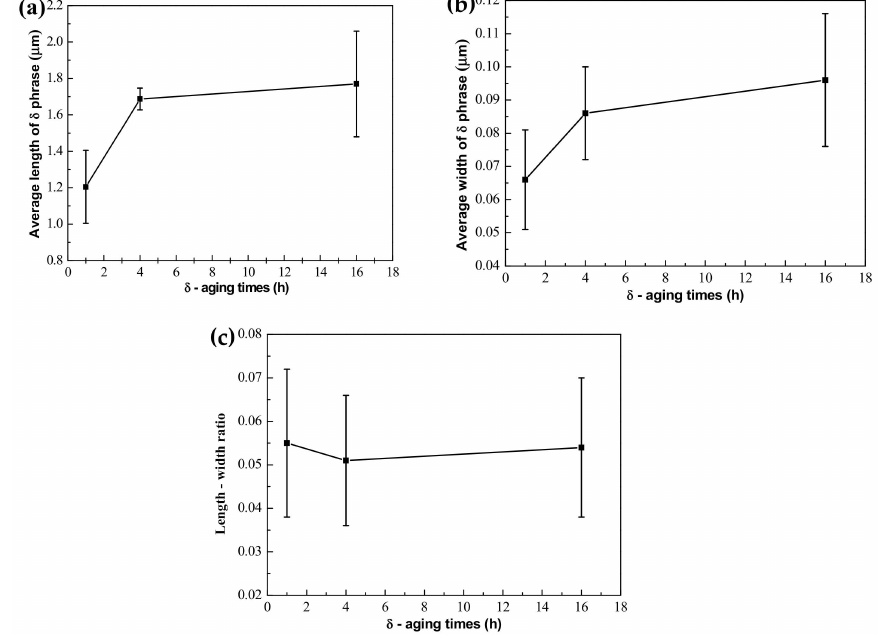
Figure 3. Quantitative measurements of the δ phase in the LSFed Inconel 718 superalloy after ageing treatment (( a – c ) are average length, average width, and length–width ratio of the δ phase,